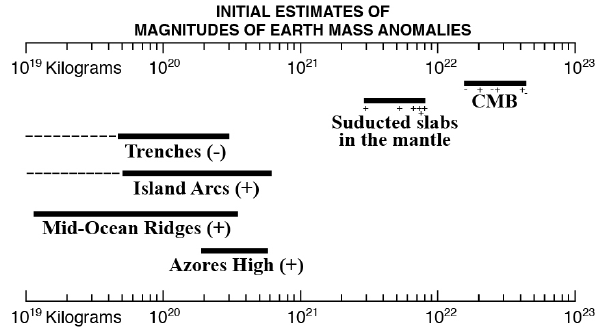
Figure 5. Initial estimates of the magnitudes of Earth mass anoma- lies. Estimates are calculated from ratios of gravity anomaly divided by geoid anomaly values at anomaly